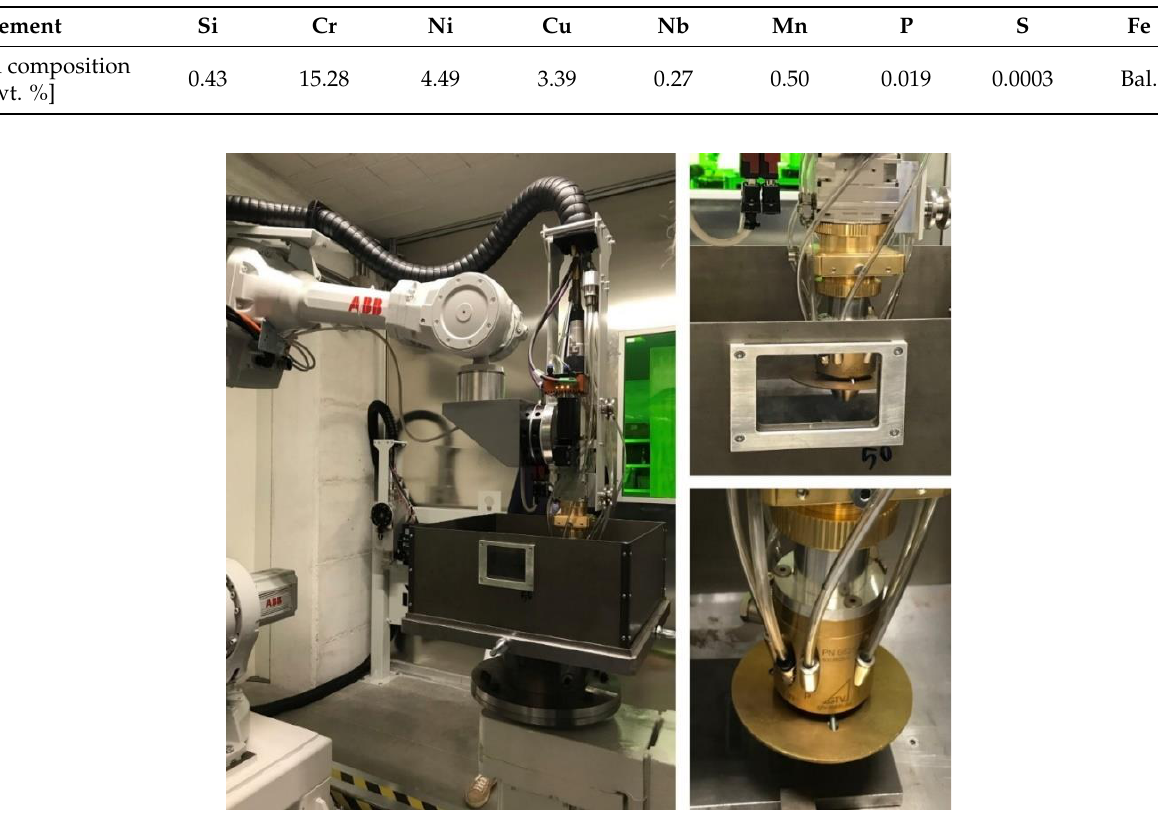
Figure 1. ABB laser robot with 6 nozzle heads used to perform the DED process.